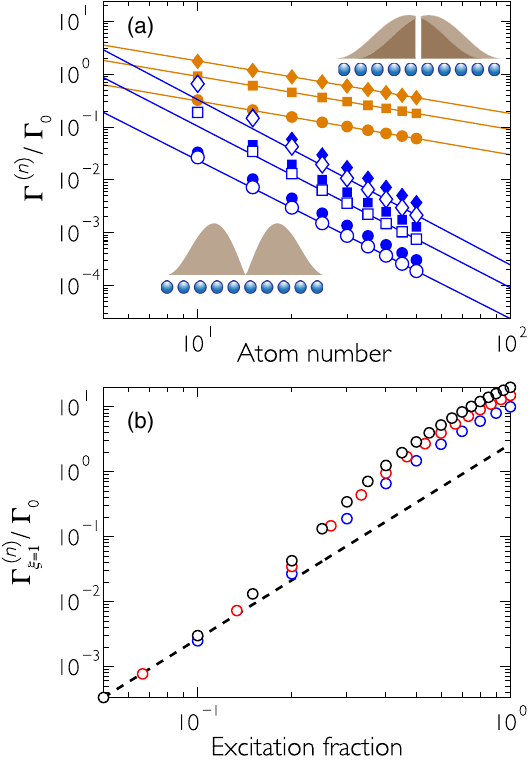
FIG. 10. Multiexcitation states in a 1D chain of two-level atoms with polarization parallel to the chain. (a) Scaling of the decay = Γ 0 of the most subradiant n -excitation state with the rate Γ ð n Þ ξ ¼ 1 atom number N (blue open symbols). For comparison, the decay rates of the Fock state constructed with n excitations in the most subradiant single-excitation mode Γ ð n Þ (orange solid symbols) b and for the fermionic ansatz Γ ð n Þ ans (blue solid symbols) are shown ( n ¼ 2 , 3, 4 are denoted by circles, squares, and diamonds, ∼ N − 3 respectively). The lines are polynomial fits close to Γ ð n Þ ξ ¼ 1 ∼ N − 1 , respectively. The sketches on top of the atomic and Γ ð n Þ b chain represent the two-excitation density profile. (b) Scaling of = Γ 0 of the most subradiant state with the the decay rate Γ ð n Þ ξ ¼ 1 excitation density n=N . The dashed line corresponds to the predicted scaling ∼ ð n=N Þ 3 valid at low-excitation density ( n=N ≪ 1 ). Blue, red, and black are for N ¼ 10 , N ¼ 15 , and N ¼ 20 , respectively. All plots are for d= λ 0 ¼ 0 . 3 and atomic polarization parallel to the One can also numerically evaluate the error ε in overlap between the most subradiant state and an ansatz state,